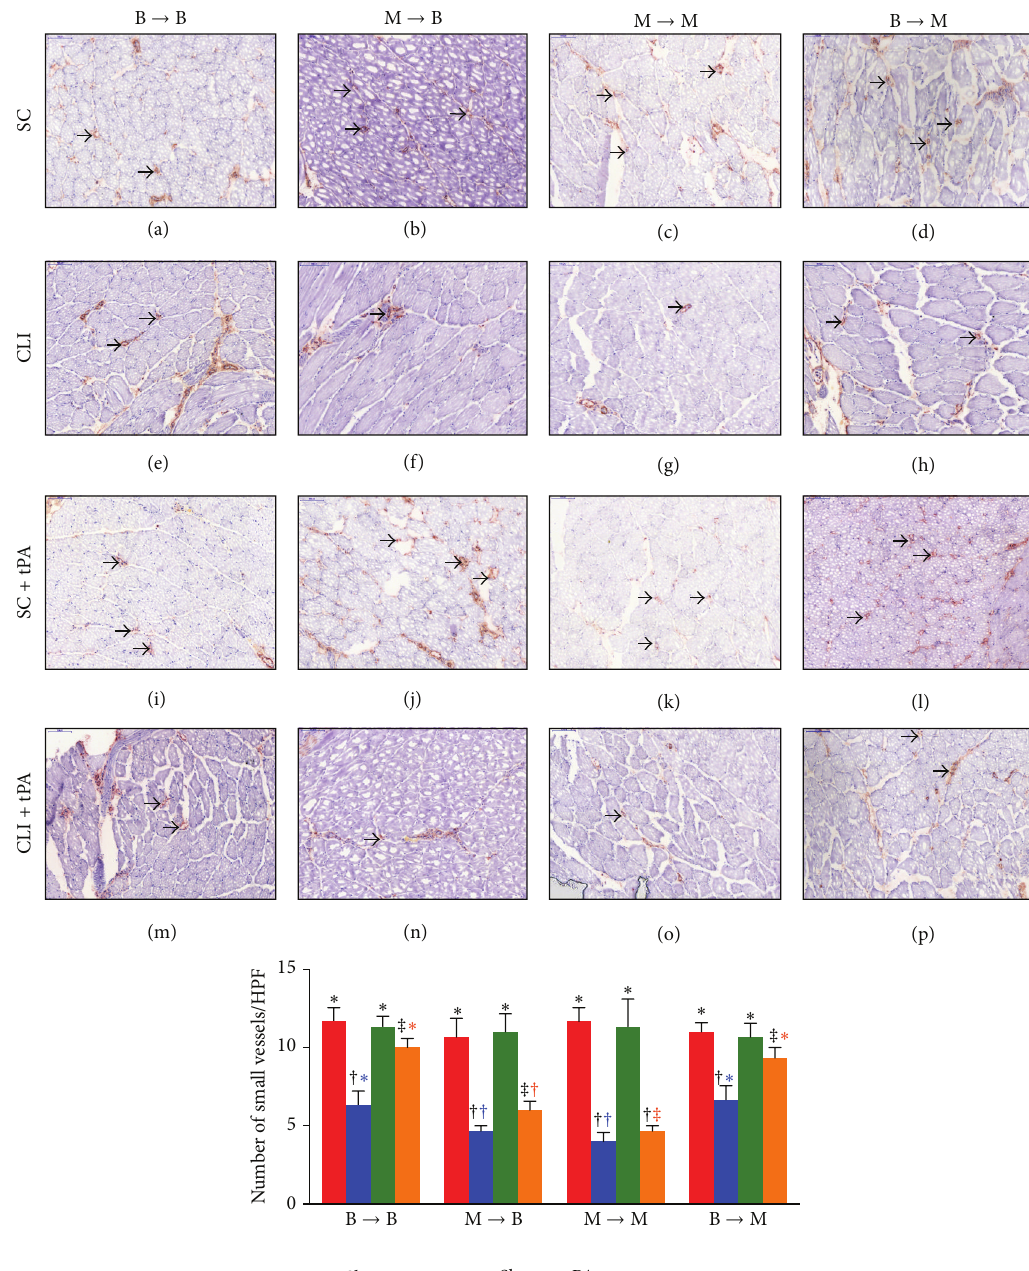
Figure 8: Immunohistochemical (IHC) staining for alpha-smooth muscle actin ( 𝛼 -SMA) to detect small vessels in ischemic quadriceps at day 14 after critical limb ischemia (CLI) induction. (a–p) IHC staining to examine the distribution of 𝛼 -SMA + small vessels (black arrows) in ischemic area in four treatment conditions of four groups. (1) Statistical analysis for subgroups of each group. (1) In B → B group, subgroups with different black symbols ( ∗ , † , and ‡ ), 𝑝 < 0.05 . (2) In M → B group, subgroups with different black symbols ( ∗ , † , and ‡ ), 𝑝 < 0.05 . (3) In M → M group, subgroups with different black symbols ( ∗ , † ), 𝑝 < 0.05 . (4) In B → M group, subgroups with different black symbols ( ∗ , † , and ‡ ), 𝑝 < 0.05 . (2) Statistical analysis for group comparison with respective treatment condition. (1) For SC subgroup (red bar chart), 𝑝 > 0.05 . (2) For CLI subgroup (blue bar chart), groups with different blue symbols ( ∗ , † ), 𝑝 < 0.05 . (3) For SC + tPA treatment condition (green bar chart), 𝑝 > 0.05 . (4) For CLI + tPA treatment condition (orange bar chart), groups with different orange symbols ( ∗ , † , and ‡ ), 𝑝 < 0.05 . All statistical analyses were performed by one-way ANOVA followed by Bonferroni multiple comparison post hoc test. SC = sham control; tPA = tissue plasminogen activator. 𝑛 = 6 for each